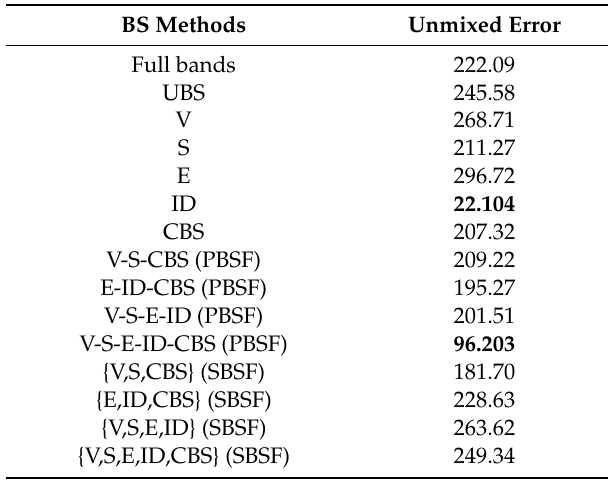
Table 6. n BS estimated by HFC / NWHFC (Harsanyi–Farrand–Chang / Noise-whitened HFC). P F = 10 − 1 P F = 10 − 2 P F = 10 − 3 P F = 10 − 4 P F = 10 − 5